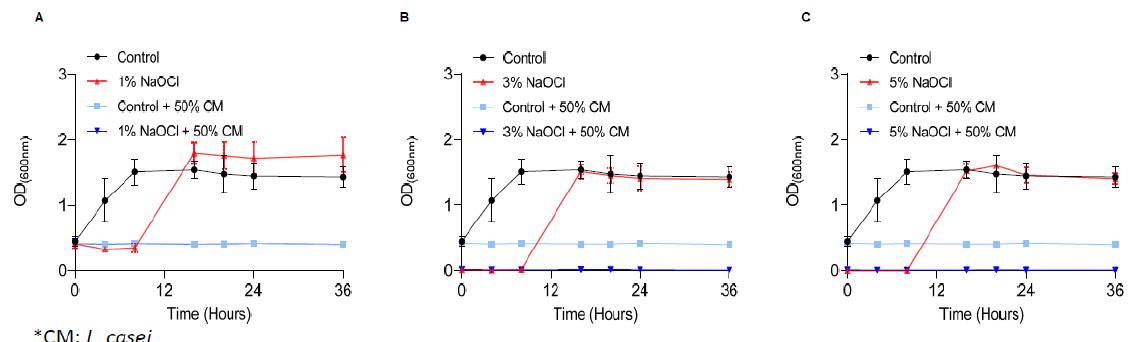
Figure 4. Secreted products of L. casei prevent the regrowth of E. Faecalis biofilm cells. E. faecalis cells were diluted 1:25 into a fresh TSB medium. 1000 µ L of cultures were split into a 12-well polystyrene plate and further incubated at 37 ◦ C for 24 h. Biofilm was untreated or treated with different concentrations of NaOCl (1% ( A ), 3% ( B ), or 5% ( C )) for 5 min. Bacterial cells were collected with 200 µ L PBS and added to 3 mL of TSB medium (applied with 0.5% glucose) either mixed 1:1 with conditioned medium of L. casei or not. Cells were regrown at 37 °C with shaking. OD600 was measured at different time points (0 h, 4 h, 8 h, 16 h, 20 h, 24 h and 36 h) as described above. Graphs represent the mean ± SD from three independent experiments ( n = 9). Statistical analysis was performed using two-way ANOVA followed by Dunnett’s multiple comparison test. p < 0.05 was considered statistically